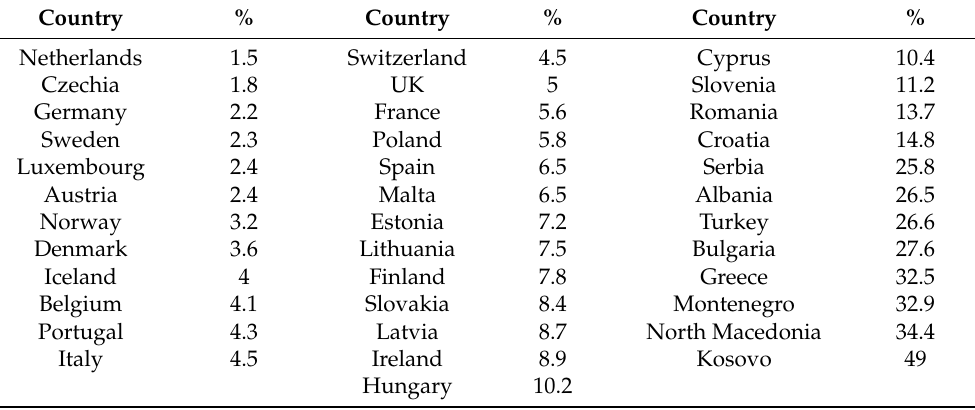
Table 6. Percentage of persons from the total population who are in arrears on utility bills in 2019 in European countries. Country % Country %